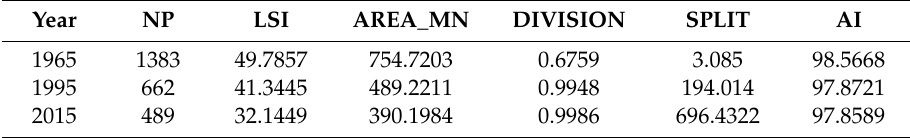
Table 5. Landscape changes of the marsh in the SSP in the past five decades.